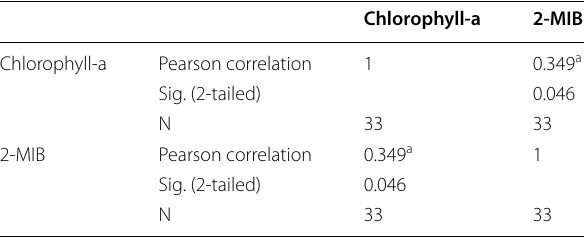
Table 5 Correlation analysis of chlorophyll-a and